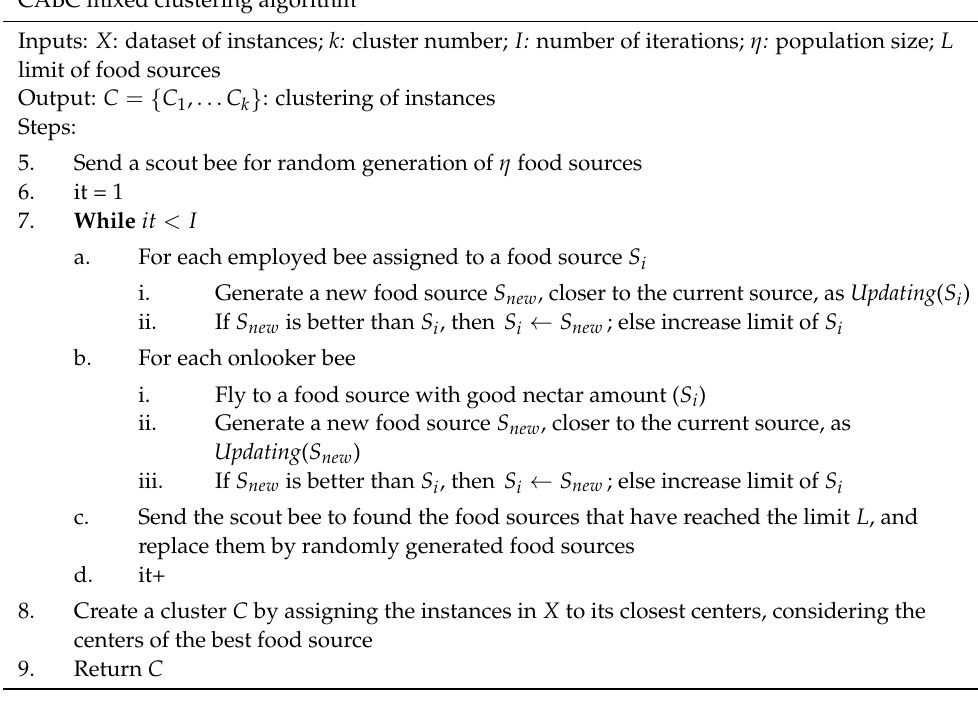
Algorithm 5. Pseudo code of the CABC algorithm to clustering mixed data. CABC mixed clustering algorithm